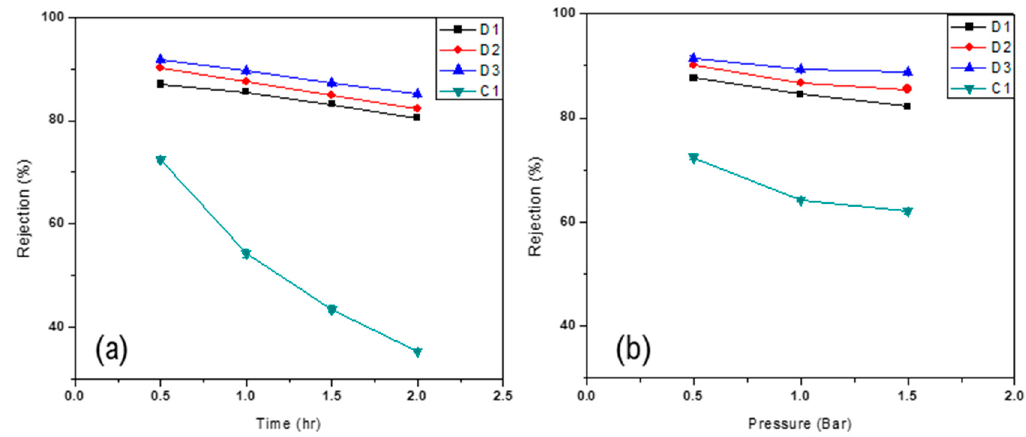
Figure 8. Oil rejection of D ‐ type membranes as a function of ( a ) time at 0.5 bar and ( b ) pressure.